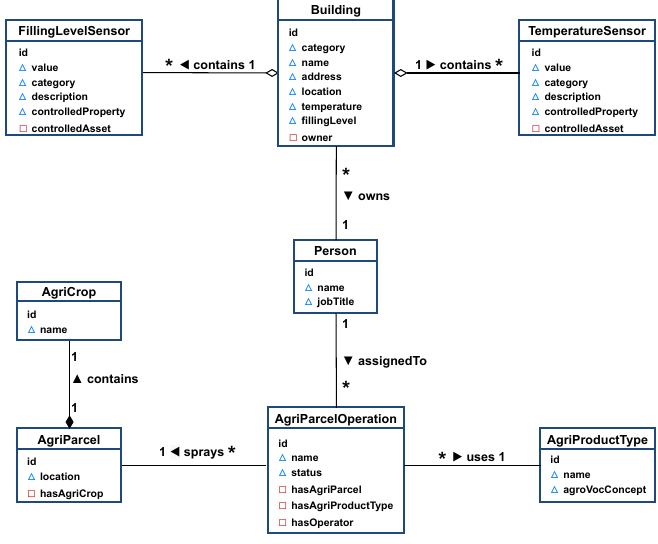
Figure 3. Entities and relationships in the